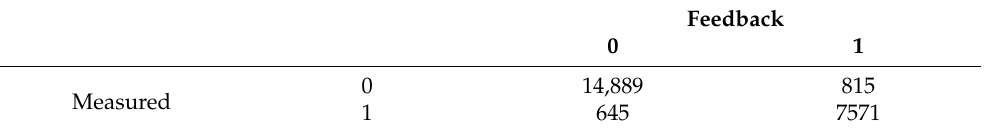
Table 7. The confusion matrix of features extracted after video-labeling validation.